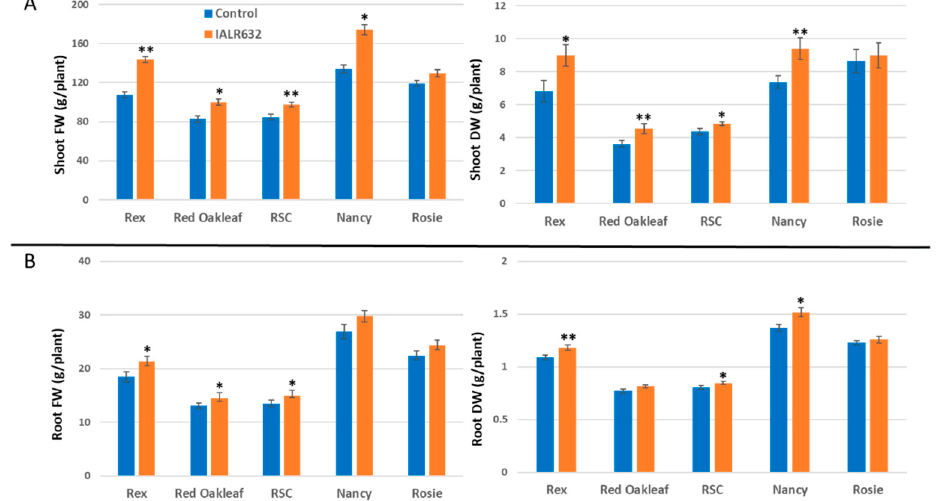
Figure 4. Effects of IALR632 on shoot ( A ) and root ( B ) growth of 5 cultivars in greenhouse NFT system (12 April 2021 to 4 May 2021). *, ** on the column mean statistically significant difference at p < 0.05 and 0.01, respectively.